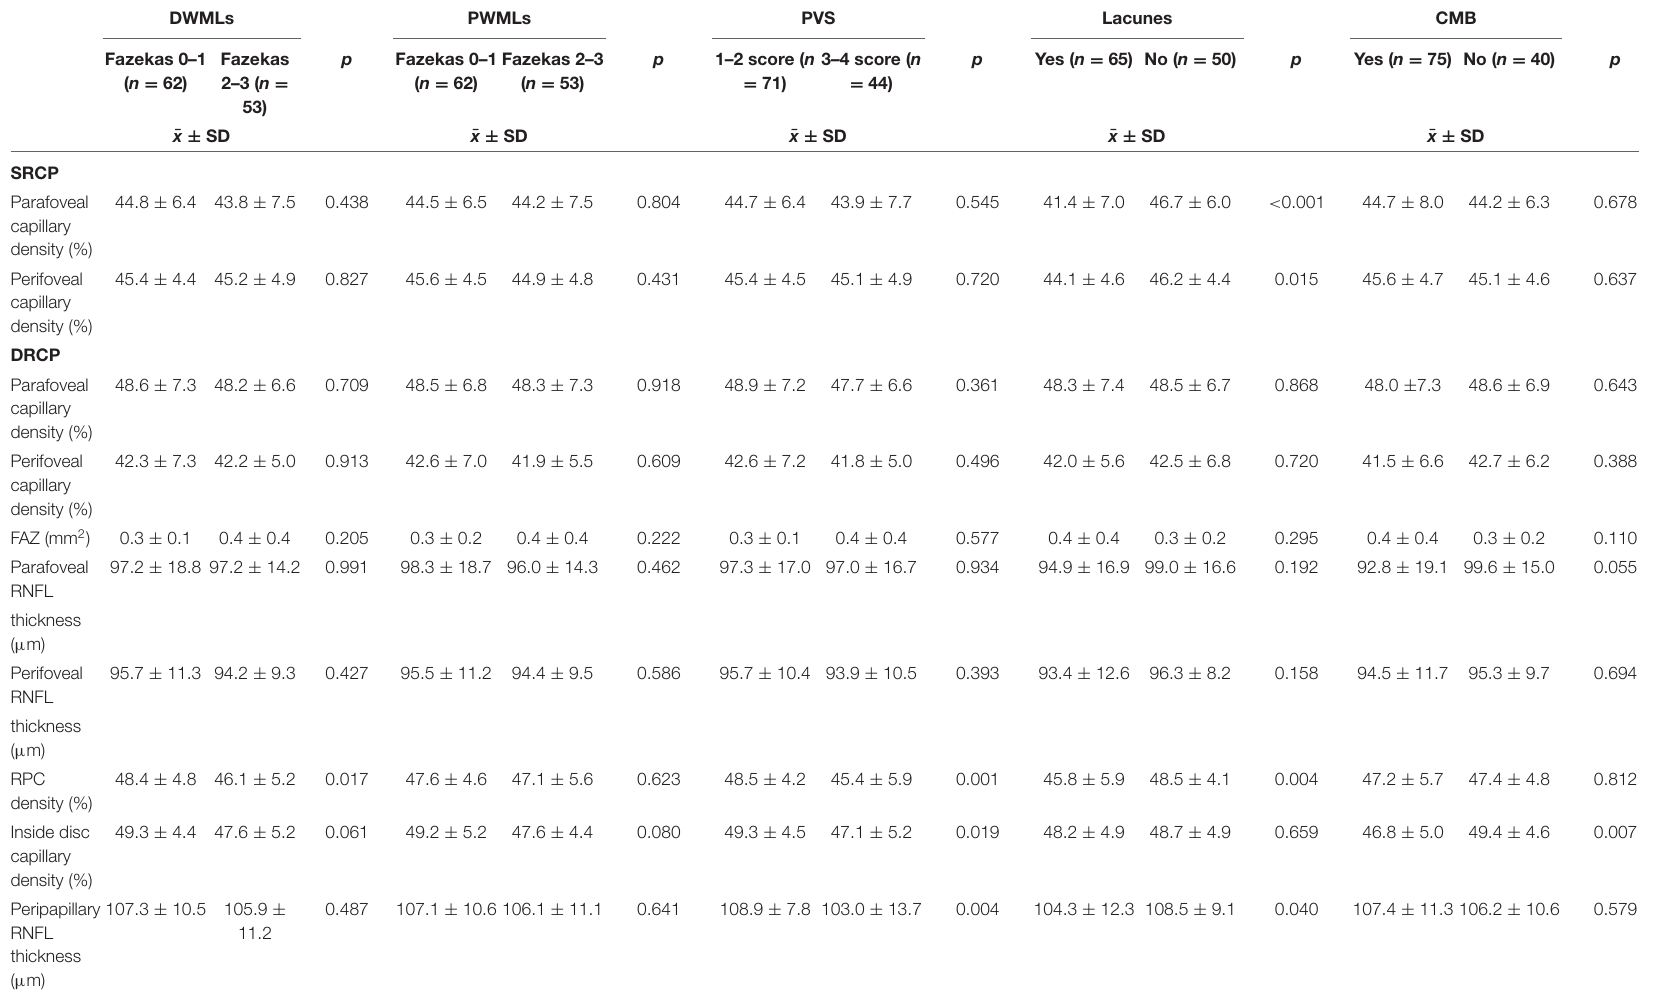
TABLE 2 | Univariate analysis of OCT and OCTA parameters for patients with